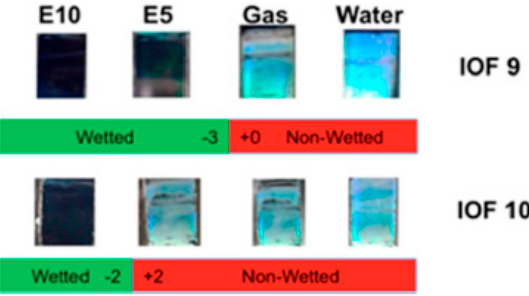
Figure 4. Optical images show the wettability tests on the coated IOF strips when dipped in gasoline/ethanol mixtures. Reproduced with permission from [28].